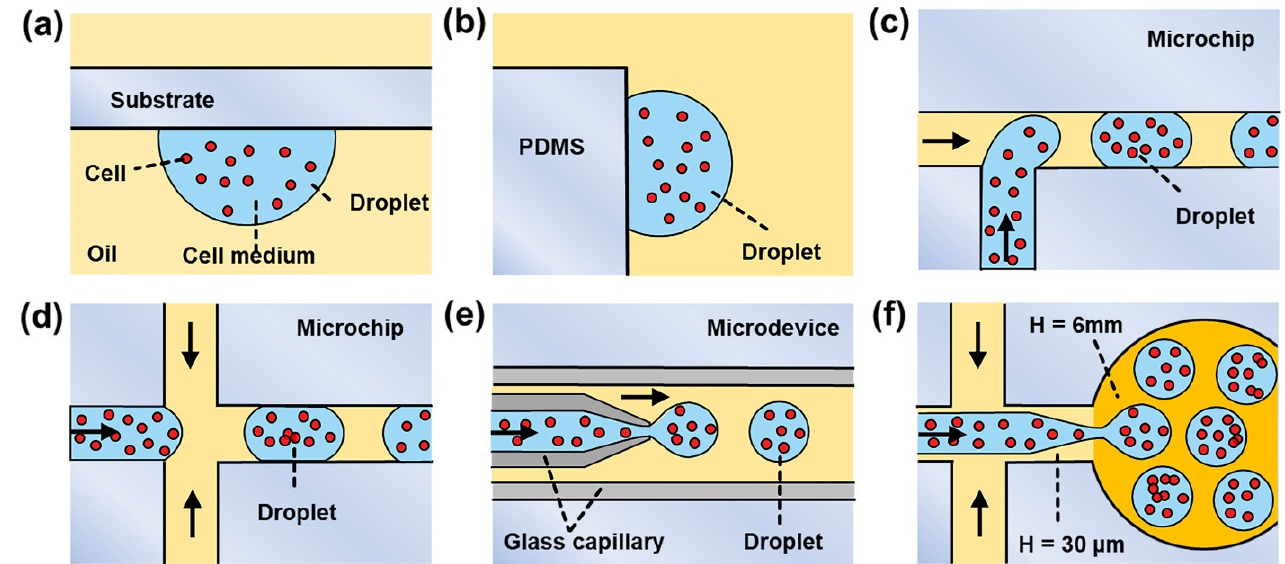
Figure 1. Typical microfluidic 3D cell culture methods: ( a , b ) hanging drop; ( c ) T-junction; ( d ) flow- focusing; ( e ) coxial flow; ( f ) co-flow step emulsification (CFSE).